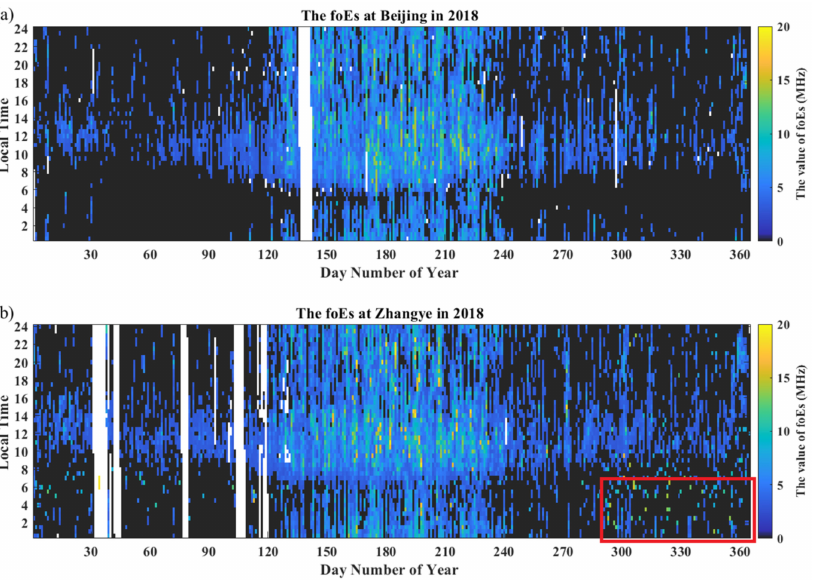
Figure 11. Variations in foEs as a function of day of the year and local time at Beijing ( a ) and Zhangye ( b )